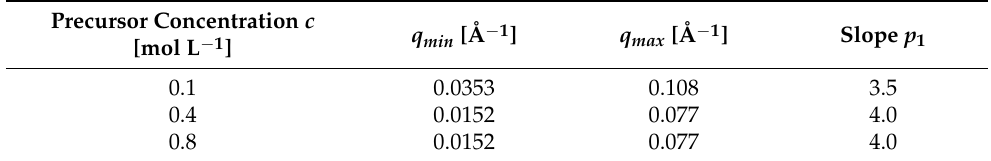
Table 1. Range of scattering vectors for the size distribution fit as well as the slope p 1 of the 1st power law fit.